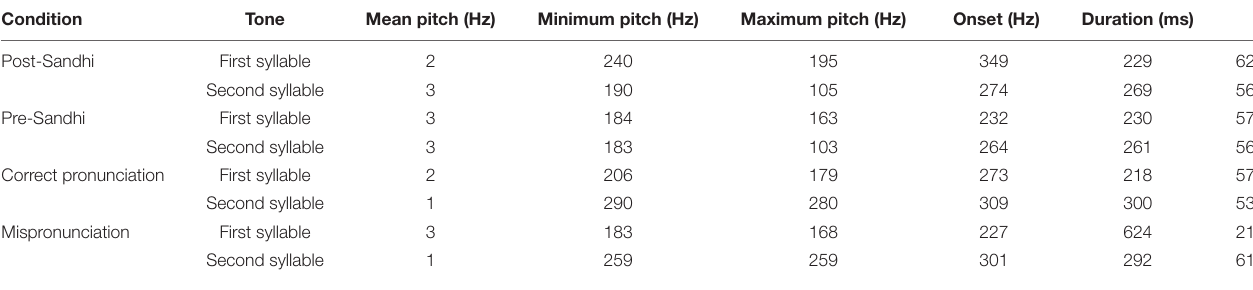
TABLE 3 | Acoustic analyses for target